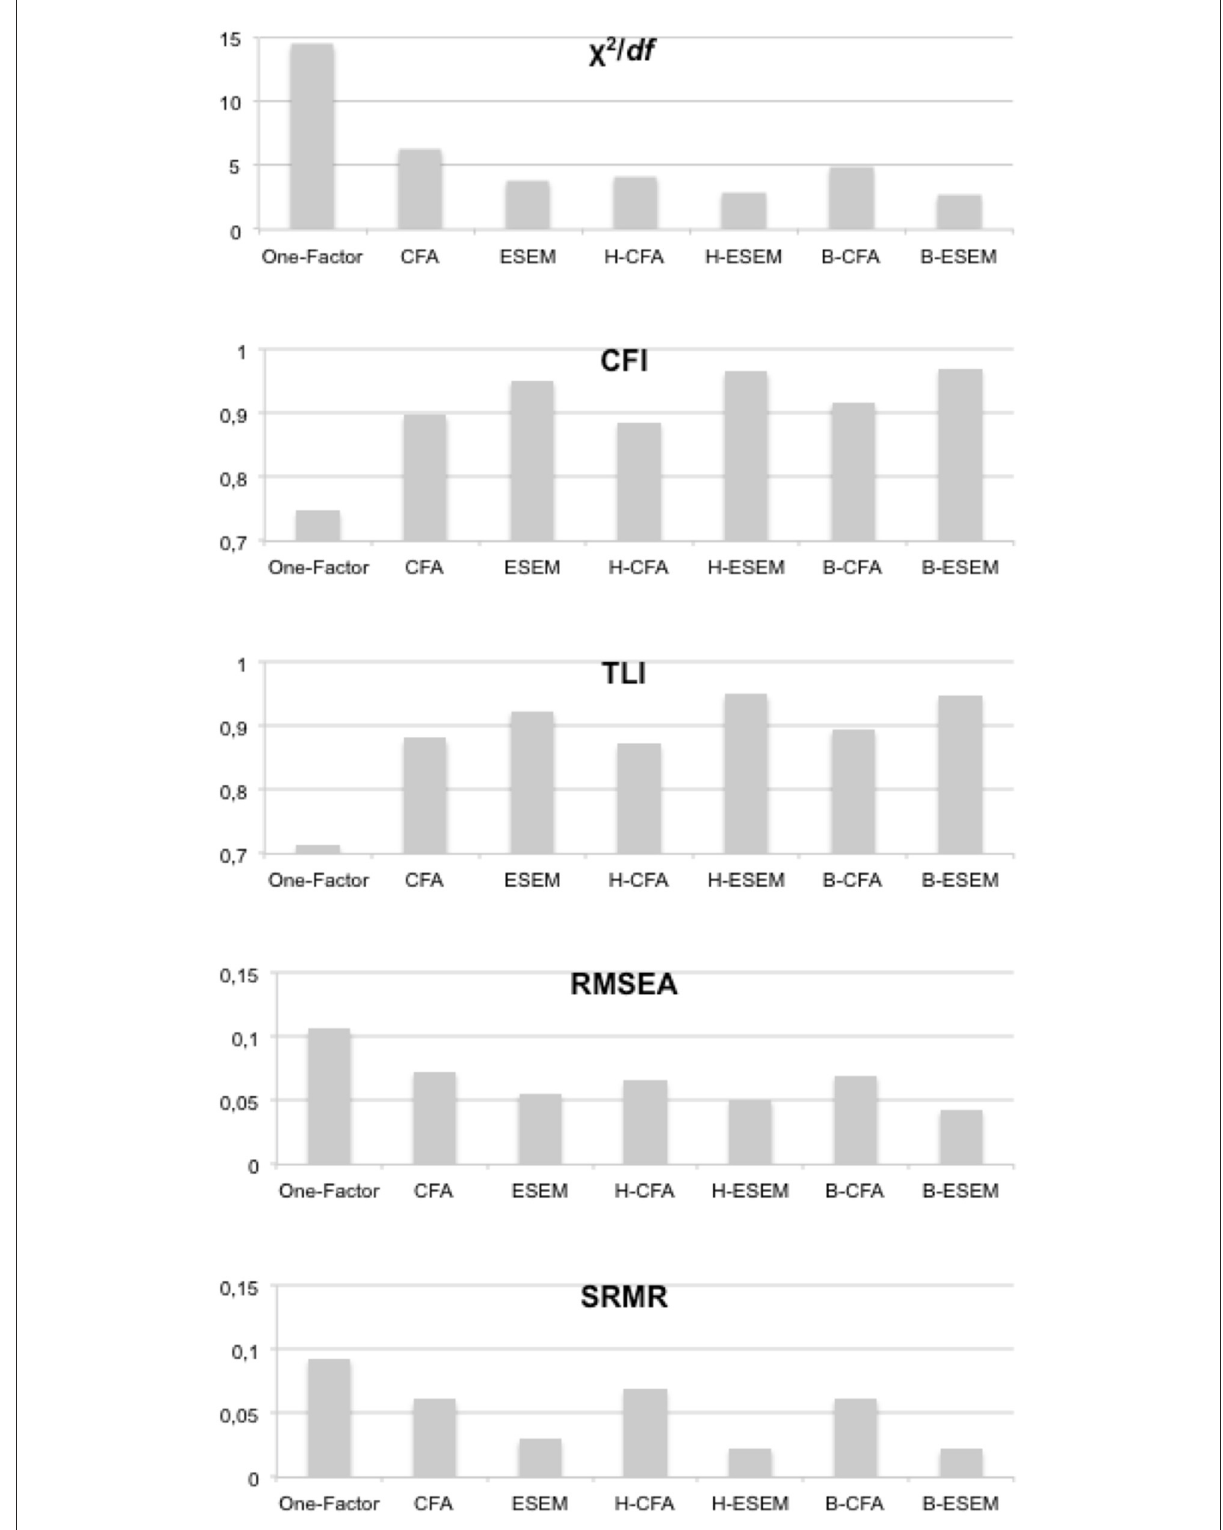
FIGURE3 Goodness-of-fit indices per model